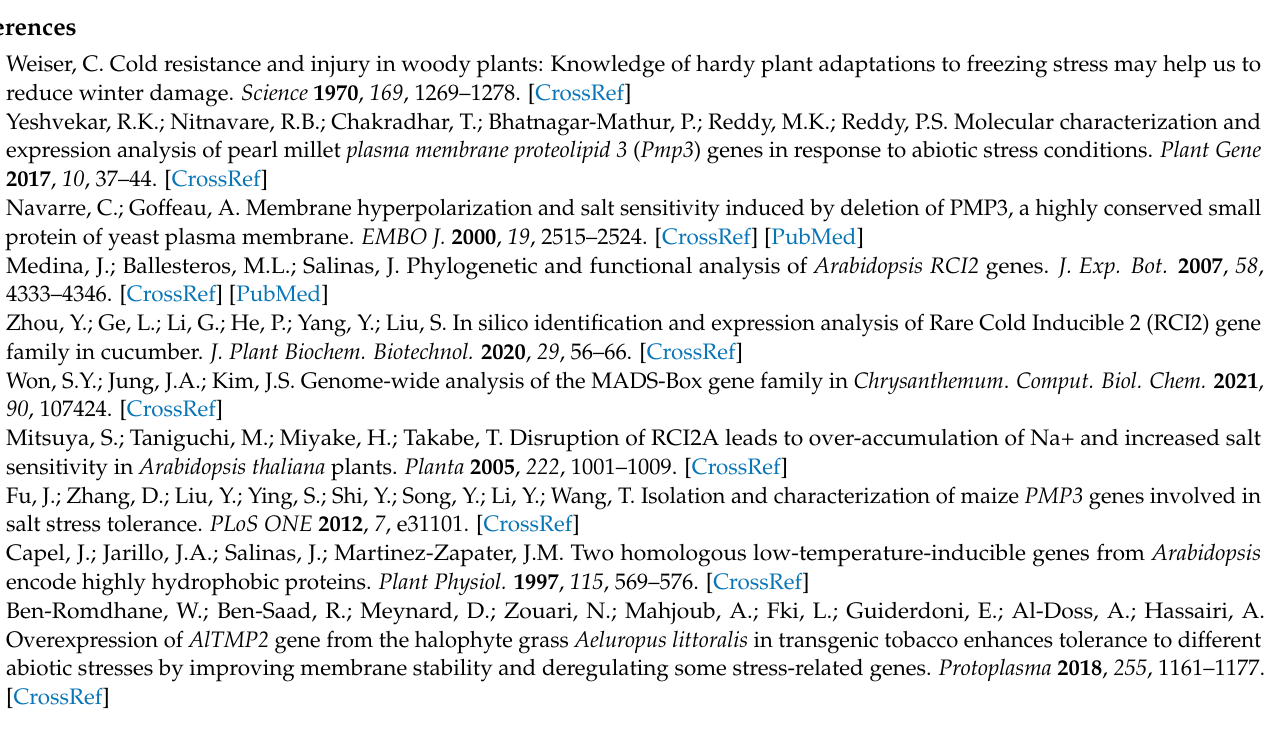
PmRCI2 s. Table S2: Expression profiles of PmRCI2 genes in different tissues. Table S3: Expression profiles of PmRCI2 genes during the process of flower bud dormancy release. Table S4: Expression profiles of PmRCI2 genes in different regions and seasons. Table S5: The Primer of qRT-PCR. Table S6: Cis-acting element on the promoter of PmRCI2